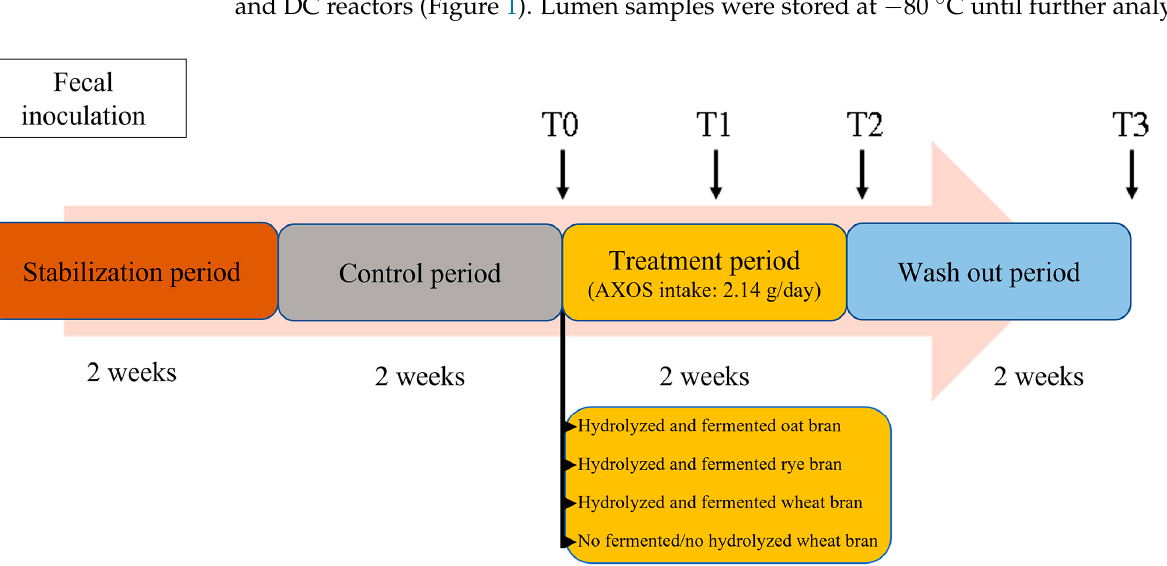
Figure 1. 4-SHIME ® experimental design. T0–T3 represent sampling points. T0 is just before the start of treatment; T1 and T2 correspond to 7 and 14 days of treatment, respectively; and T3 corresponds to 14 days of wash out.